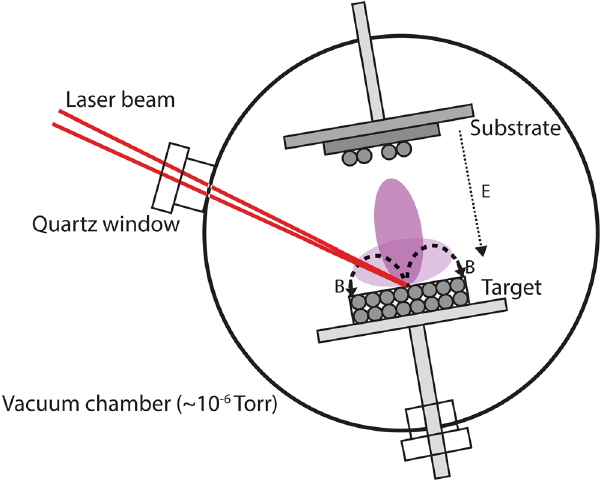
Figure 1. Combined Pulsed Laser Deposition + Magnetron Sputtering System. The target is exposed to the PLD laser (the dark purple vertical plume in the picture) and to the plasma generated by the sputtering system (in light purple in the picture) at the same time. B represents the magnetic field while E is the electric field.